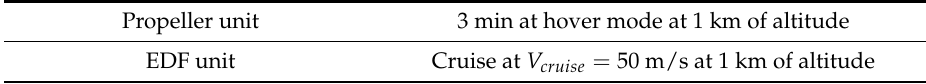
Table 1. Average operating point for the Propeller and the Electric Ducted-Fan (EDF) units. Propeller unit